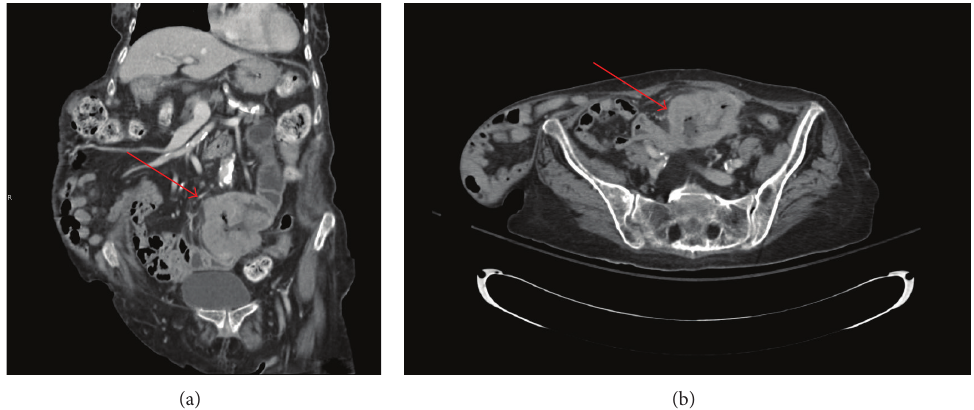
Figure 1: Axial (a) and coronal (b) projections of the computerized tomography of the abdomen. Arrows point to the small bowel tumor.